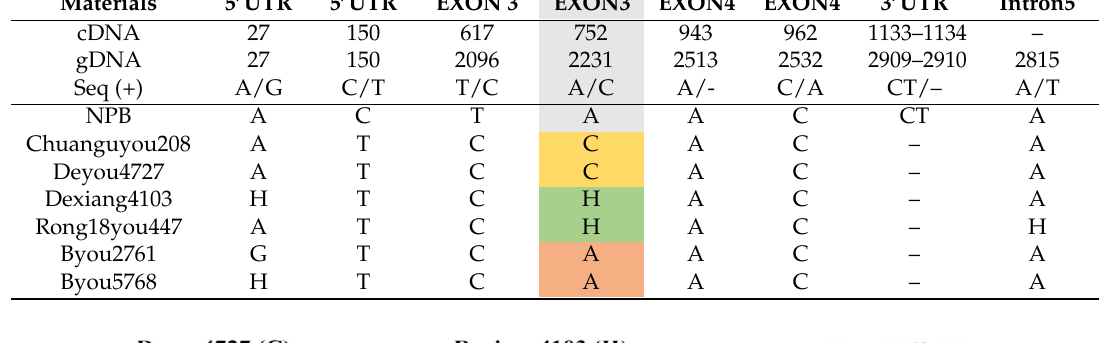
Table 2. DRO1 gene sequencing of different hybrid rice varieties.